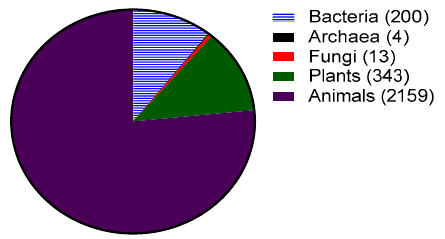
Figure 1. Sources of antimicrobial peptides (total 2818) as of September 2017 from the antimicrobial peptide database. Numbers obtained from http://aps.unmc.edu/AP/, accessed on 20 September 2017.